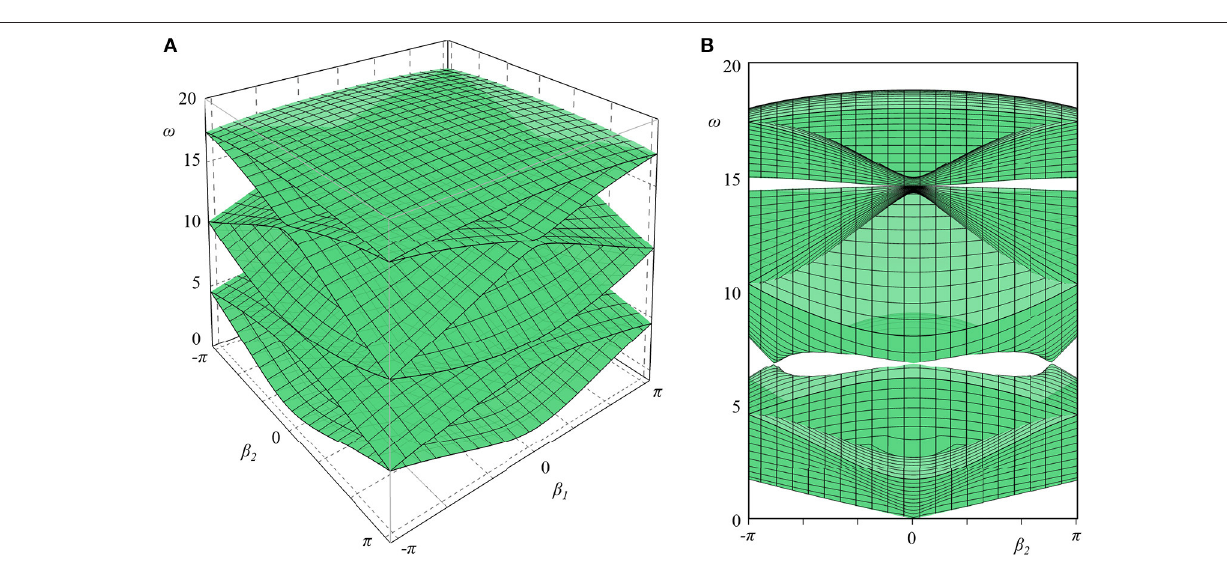
FIGURE 9 | Dispersion spectrum for the optimized beam lattice model of the anti-tetrachiral material: (A) 3D view and (B) 2D